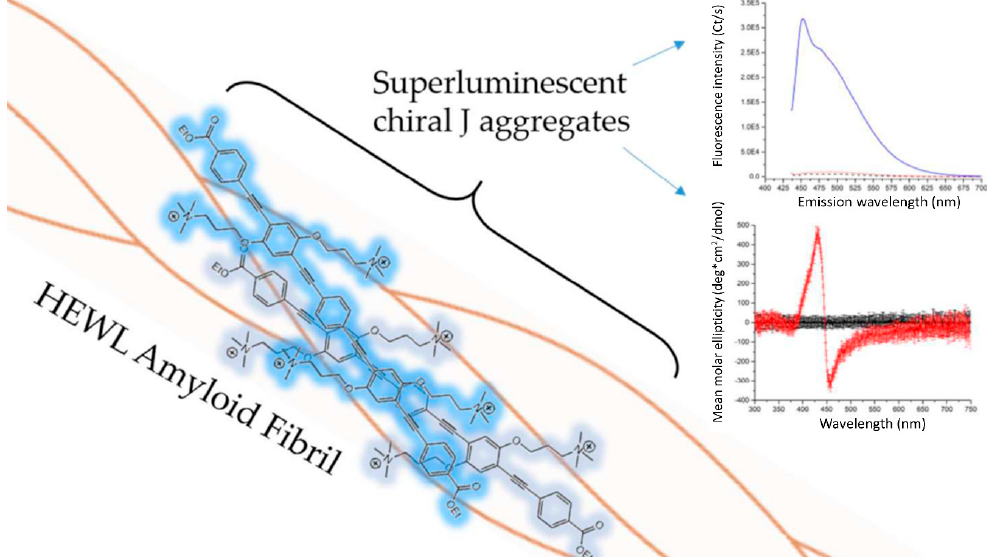
Figure 5. Oligo(p-phenylene ethynylene) (OPEs) electrolytes are forming specific chiral constructs together with amyloid fibrils. The construct exhibits enhanced fluorescence quenching and a unique CD signal. Circular dichroism spectra of OPE n = 3 (10 µ M) in phosphate bu ff er with hen egg white lysozyme (HEWL) monomer (black trace) and with HEWL (10 µ M) amyloid (red trace). Emission spectra of OPE n = 3 in phosphate bu ff er (PB, pH 7.4, 10 mM) alone (black long dashed line) with HEWL monomers (red short dashed line) and with HEWL amyloids (blue solid line), concentration: 500 nM, protein concentration: 5 µ M monomer basis / 0.25 mg / mL. Reprinted with permission from [73]. Copyright 2015 American Chemical